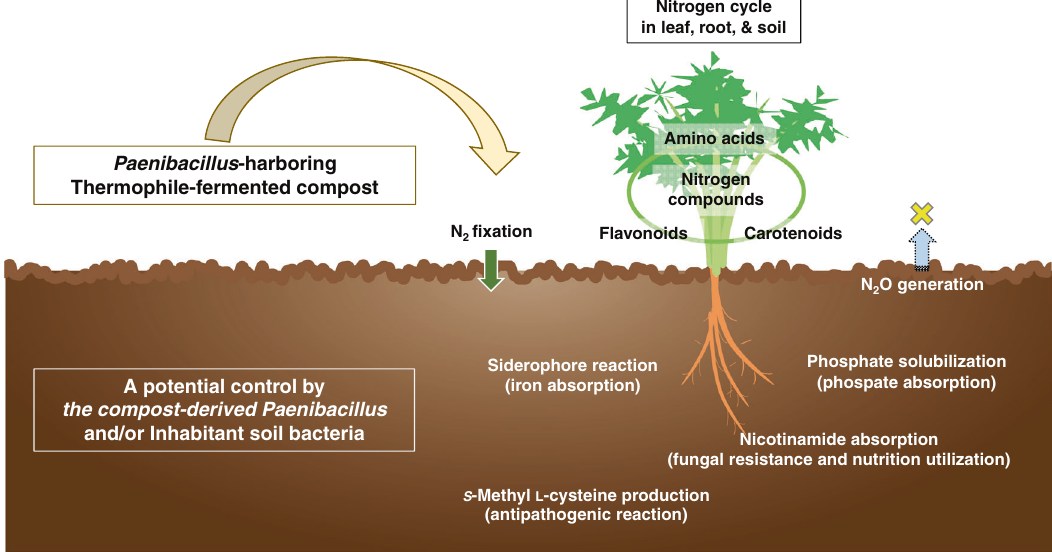
Fig. 7 A putative model consequential in this study. The interaction of compost-derived Paenibacillus , soil symbionts and their metabolites is